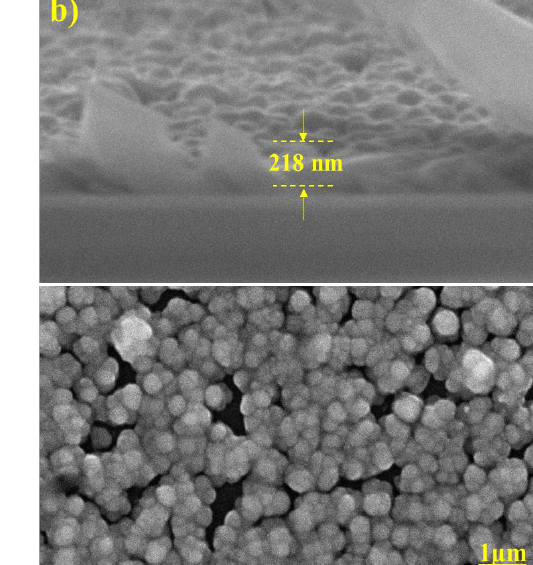
Figure 6. The difference of bandgap and Urbach energy-based molar concentration.